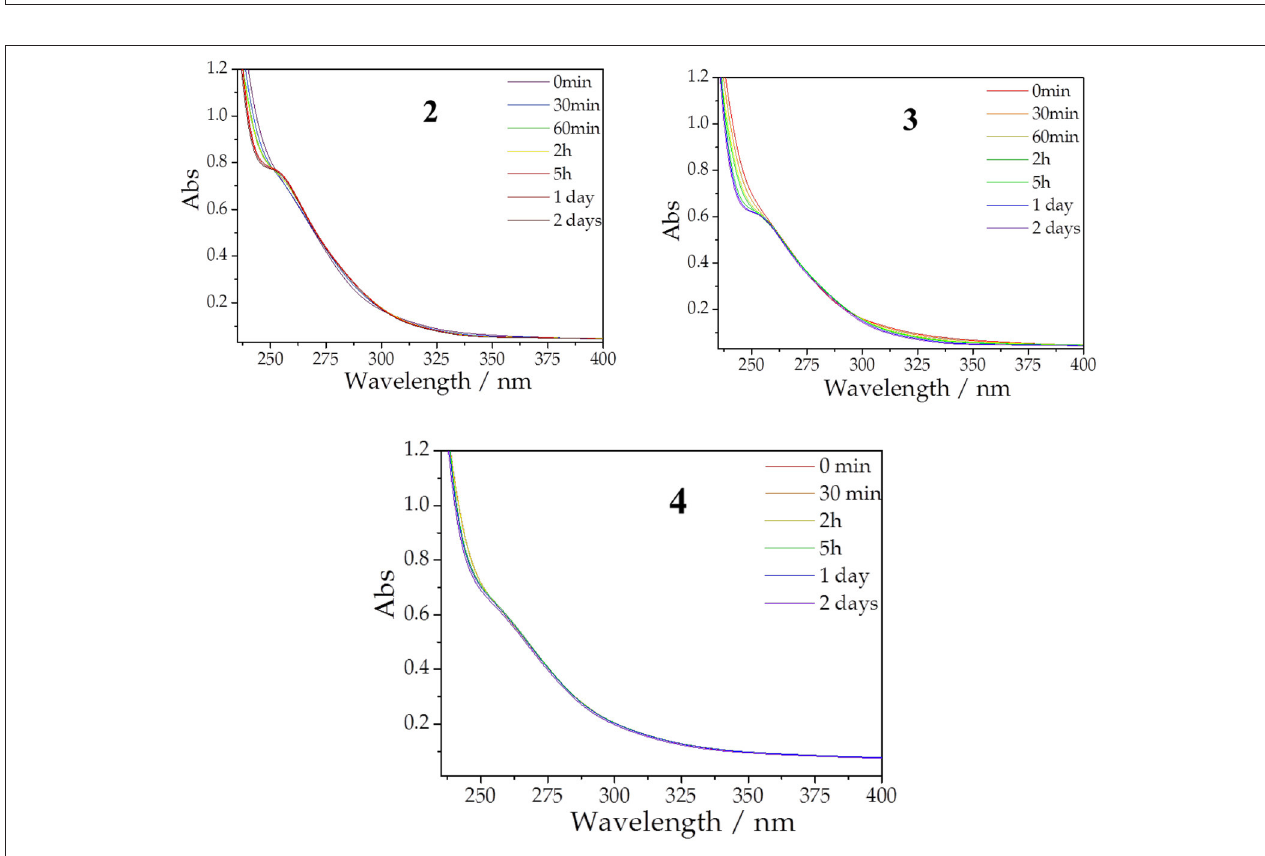
FIGURE 5 | Evolution of UV spectra of solutions of 2 , 3, and 4 at concentration of 10 − 5 M with time, recorded in a buffer solution of 0.5M sodium acetate (pH 4.8).